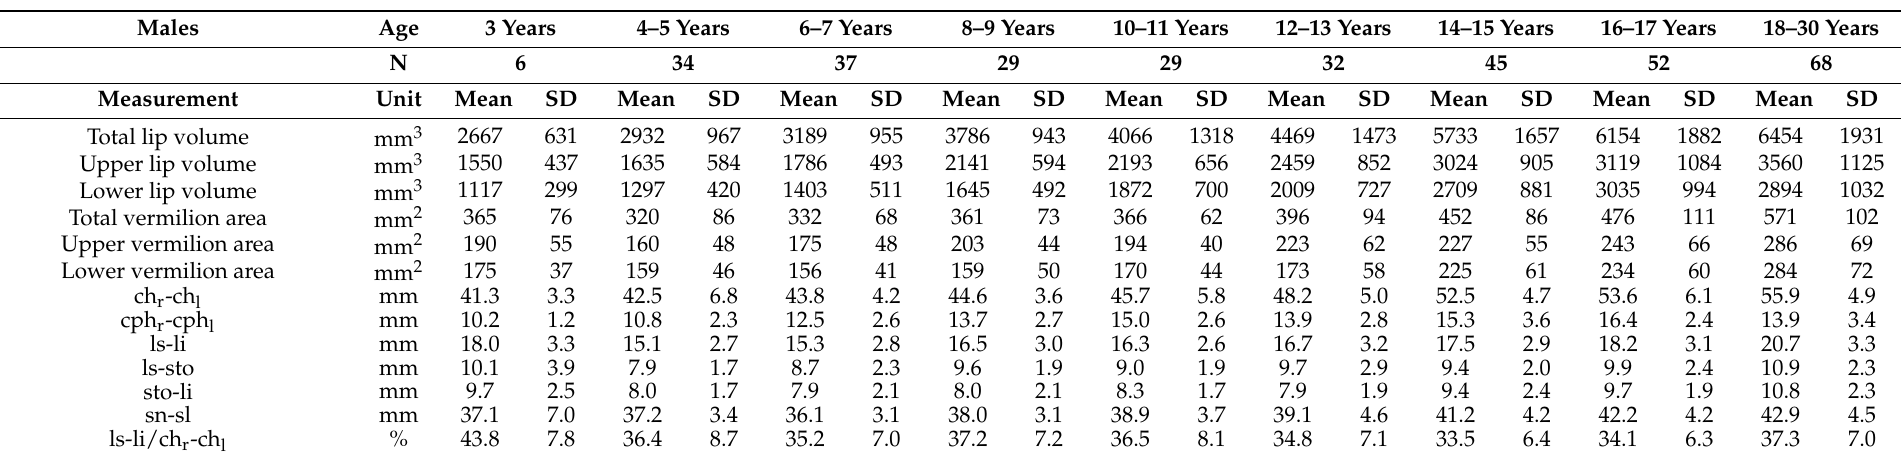
Table 2. 3D soft tissue labial volumes, areas, distances and ratios in healthy Sudanese males of Arab descent.